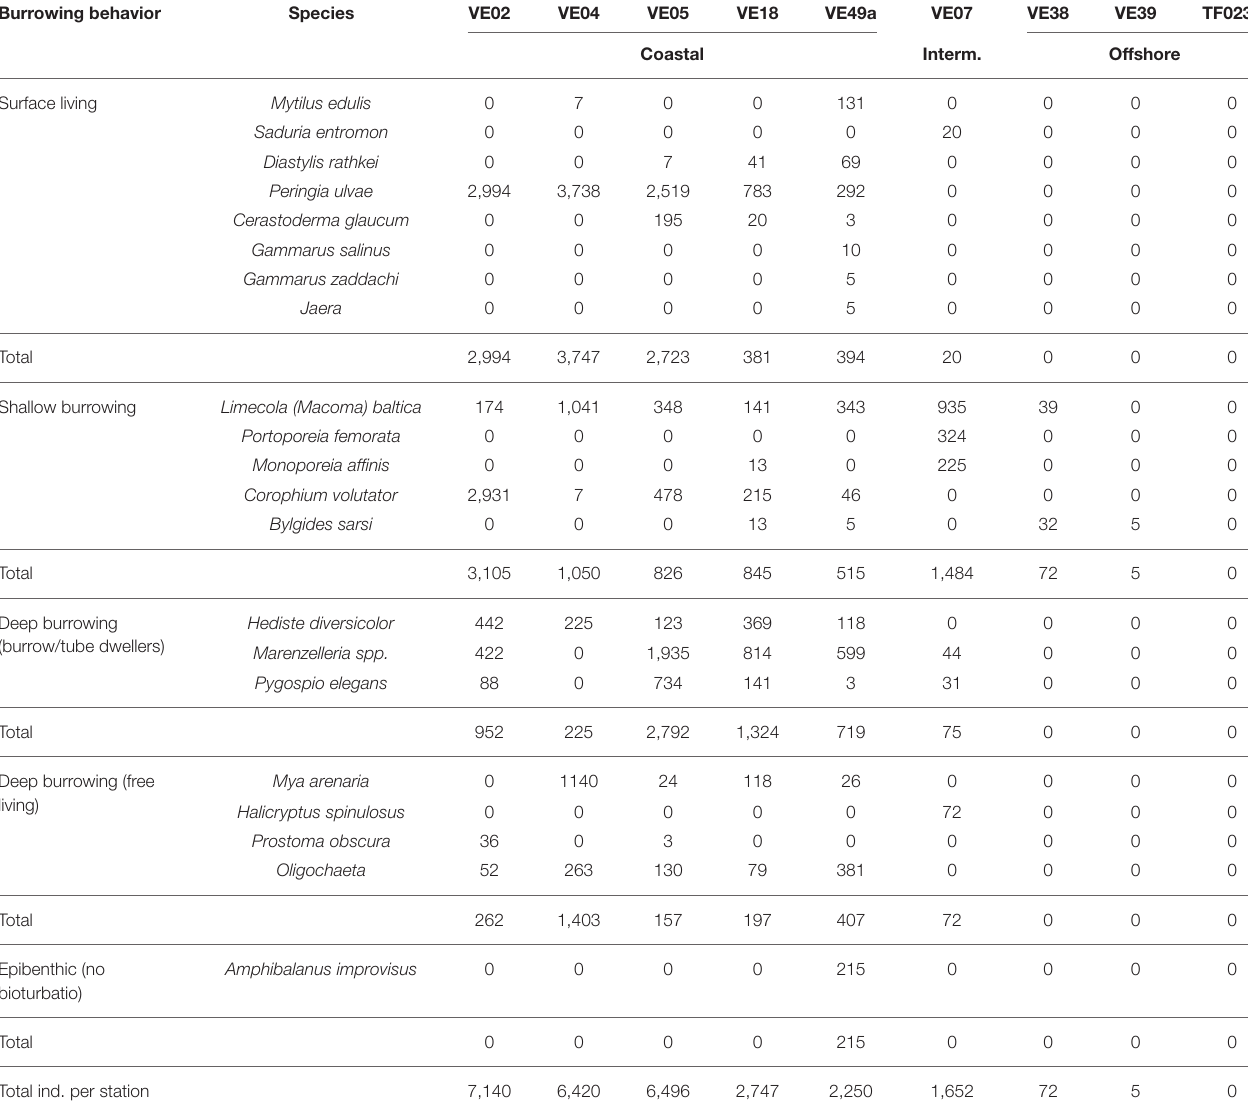
TABLE 1 | Macrofaunal abundances and individual composition at each chamber lander incubation site and the three offshore stations. Burrowing behavior